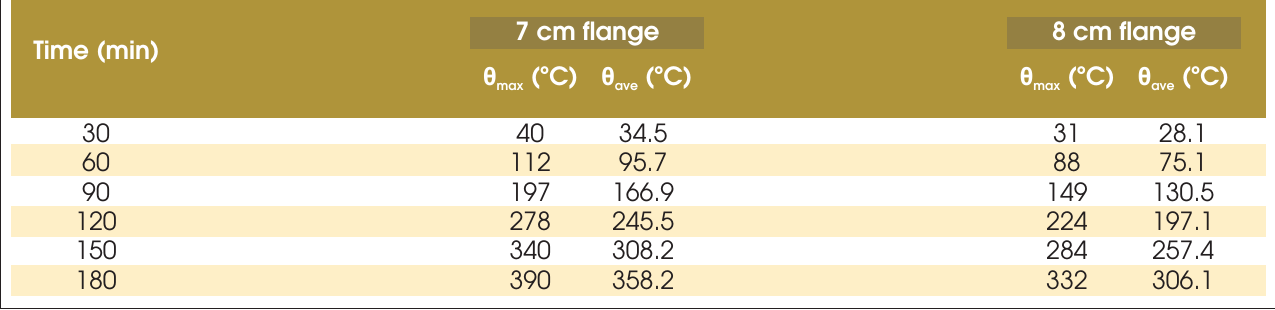
Table 17 – Maximum and average temperatures on the upper face of slab with 7 and 8 cm